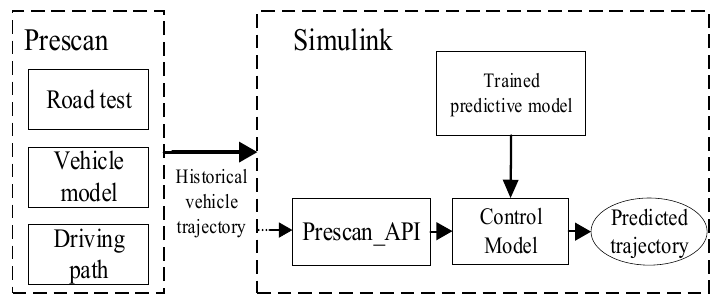
Figure 7. Joint simulation test logic. The prediction results of CS-LSTM and RA-LSTM at a certain moment under the typical working condition of left channel change were selected for demonstration. The road traffic conditions are shown in Figure 8(1a) and Figure 8(2a), respectively. Taking the position of the target vehicle at the time of prediction as the origin, this study set the road area within 70 m of the three lanes in the same direction. Among them, the red vehicle was the target vehicle, and the black vehicles were its surrounding vehicles. The speed of all surrounding vehicles was set to a constant speed. The target vehicle started to accelerate at the moment before the prediction. The signals input to Simulink were the historical trajectories of the target vehicle and the surrounding vehicles for the 3 s before the predicted moment, then the previously trained CS-LSTM and RA-LSTM prediction models were loaded to output the target vehicle driving trajectory in the next 5 s. The prediction trajectory of the model in Figure 8 consists of two parts: the yellow area of the variance visualization of the trajectory coordinate distribution and the mean value of the prediction trajectory distribution represented by triangular lines.